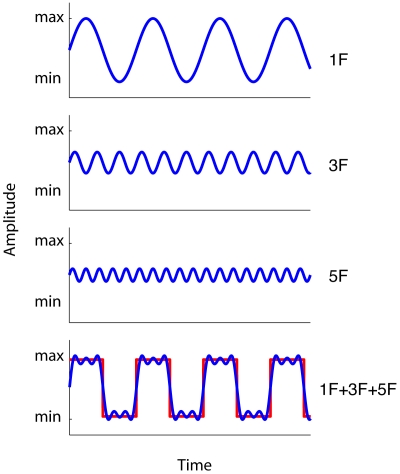
Illustration of the first three odd harmonics of the square-wave (with F the fundamental frequency).The blue line (lower panel) indicates a square-wave that results from summating the first three odd higher harmonics. The red line indicates a square-wave that would result from summating an infinite number of odd harmonics.